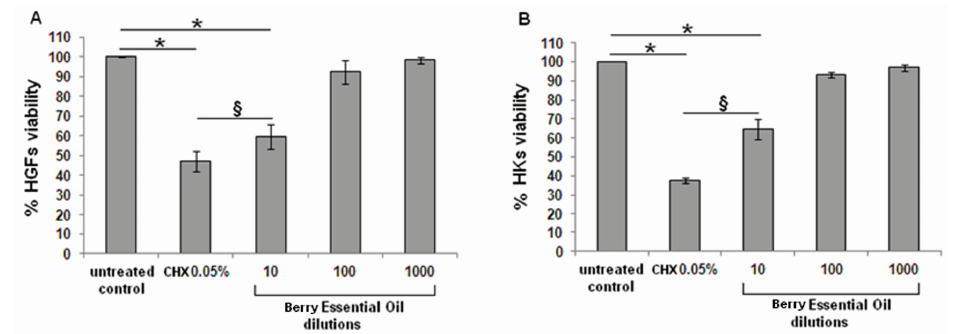
Figure 3. In vitro cytocompatibility assay. The MTT test revealed that EO (10) and chlorhexidine caused a significant reduction ( p < 0.05, indicated by the * ) of cell viability for both fibroblasts (HGFs, left) and keratinocytes (HKs, right) in comparison with untreated control cells. However, EO (10) resulted significantly less toxic than CHX for both cell types ( p < 0.05, indicated by the §). Higher oil dilutions (100 and 1000) were not toxic in comparison with control. Data are expressed as means ± standard